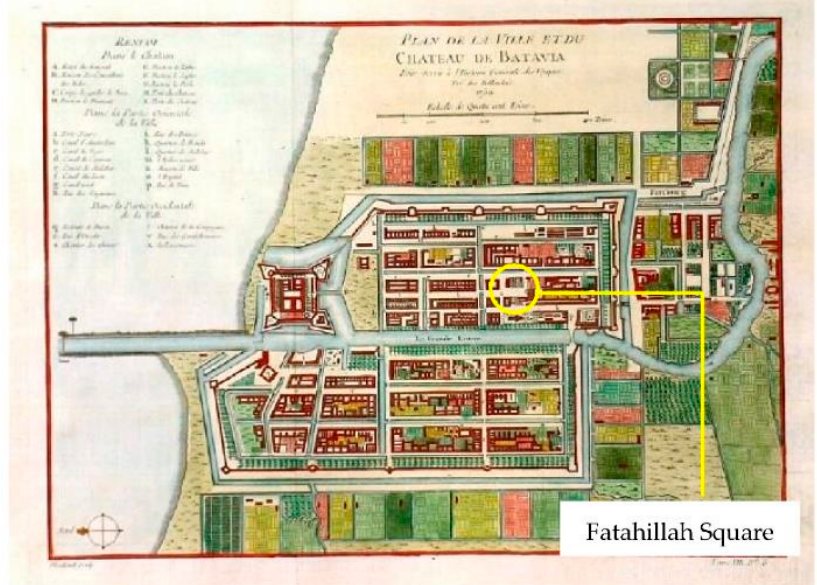
Figure 4. Map of Batavia in 1744. The city of Batavia shaped in grid urban morphology with canals as transportation mode and thick wall on outer boundary. Source: Collection of National Library of Indonesia.